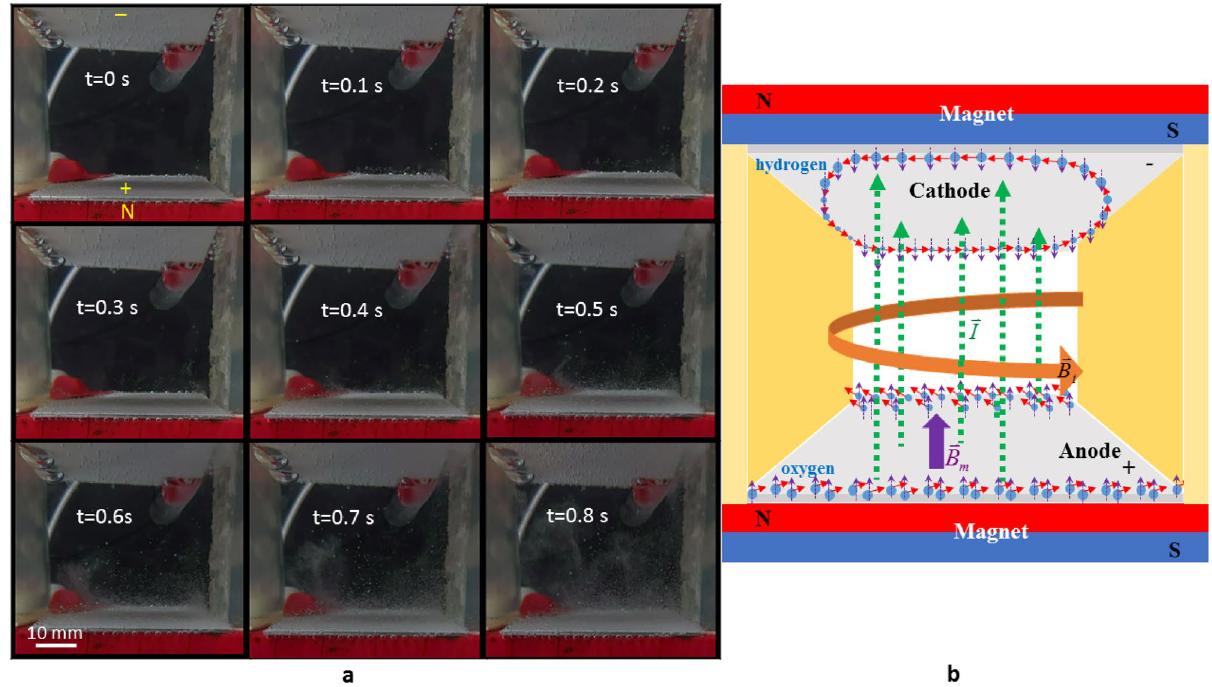
Figure 3. Swirling gas bubbles in a magnetic field that is perpendicular to the electrode surface. ( a ) Sequential images of the locomotion of the oxygen (lower electrode) and hydrogen (upper electrode) on the platinum electrodes in a perpendicular magnetic field. The experimental layout is shown in Fig. 1b with an electrical current of 5 A. ( b ) Schematic diagram of the revolution mechanism for the oxygen and hydrogen bubbles. The ⇀ B green-dash arrows are the current ⇀ I produced by the charging particles and ions flowing in the duct. i is the cylindrical magnetic field created by the current ⇀ I . The purple-dash arrows represent the induced magnetic field ⇀ B of the bubbles caused by the applied magnetic field m . The red arrows are the moving direction of the